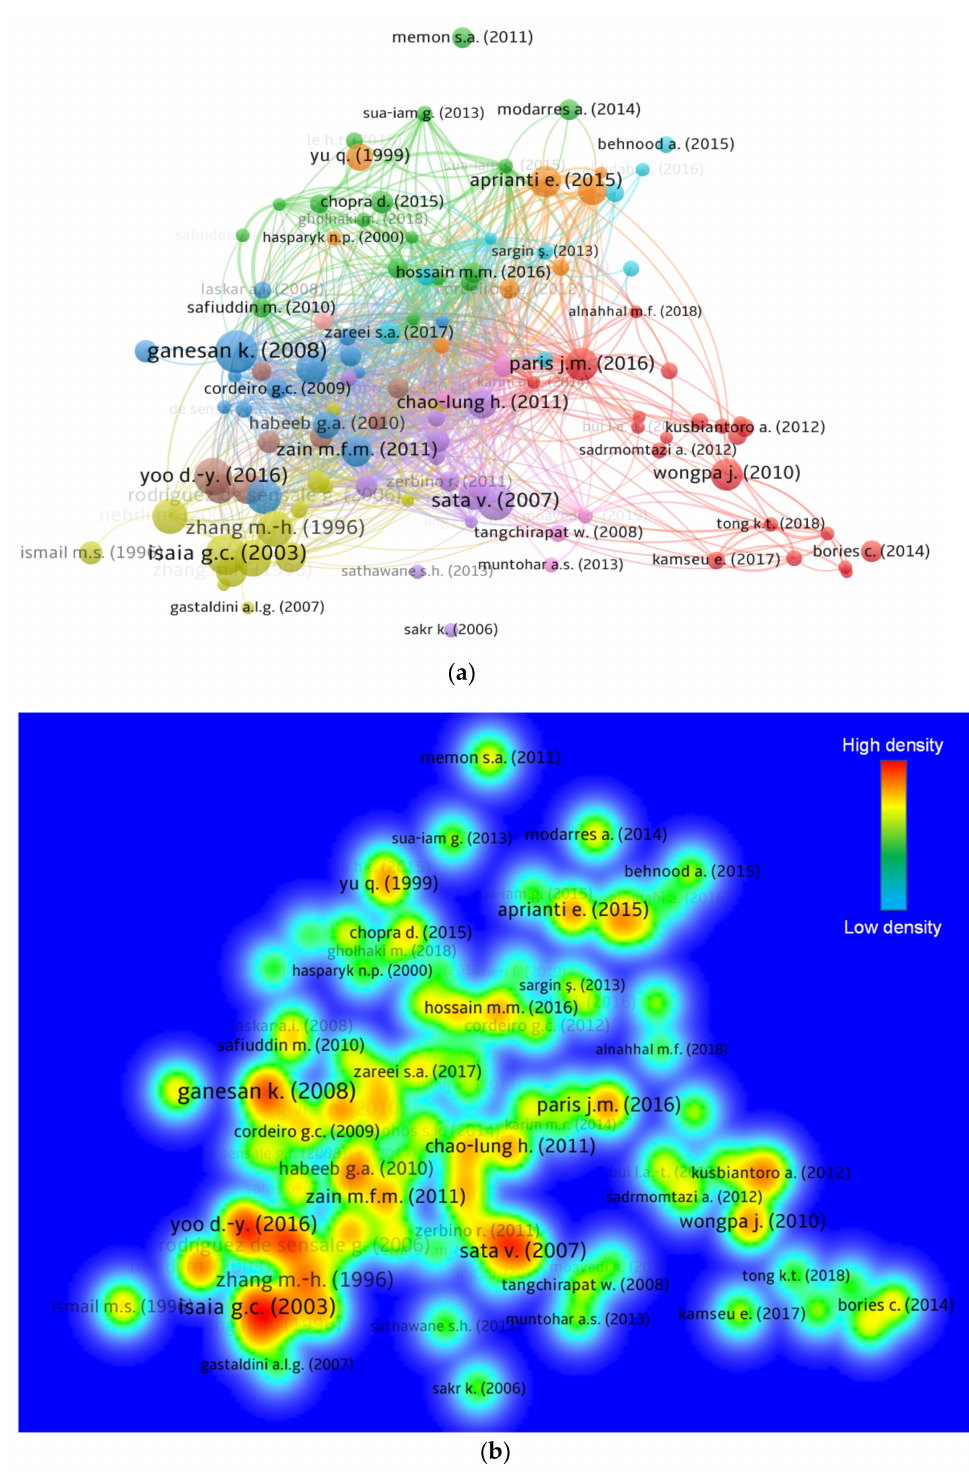
Figure 9. Scientific mapping of published articles in the related research area up to 2021; ( a ) connected articles in terms of citations, ( b ) density of connected